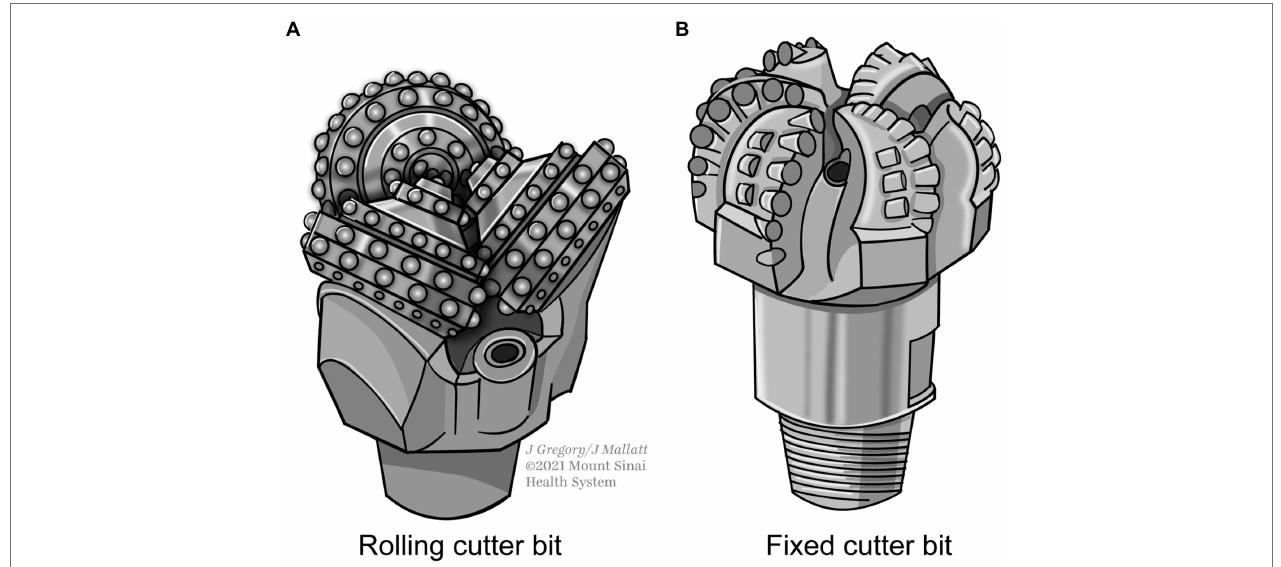
FIGURE 1 | Constraints in the design of rock-drilling bits for the petroleum industry. Only two types (A) and (B) are practical for this purpose. For photos, see